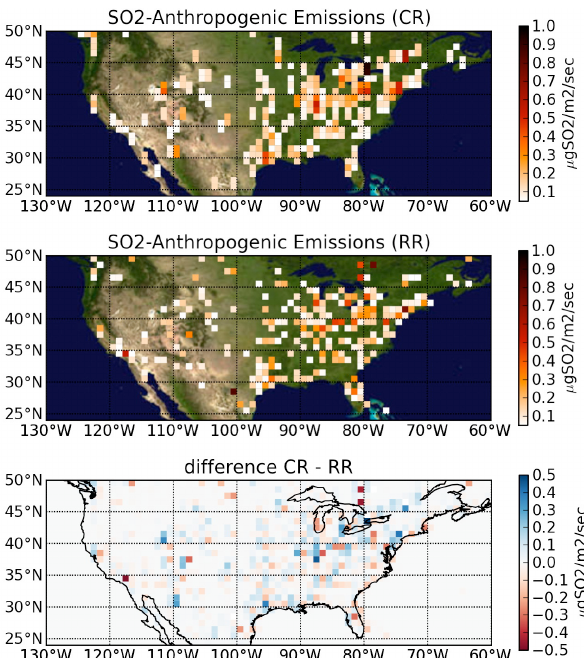
Fig. 1. SO 2 anthropogenic emissions from Streets et al. (2009) used in the control run (top), the EDGAR v4.1 dataset regridded at 1 ◦ resolution used in the revised run (middle) and the differences be- tween both (bottom) for the year